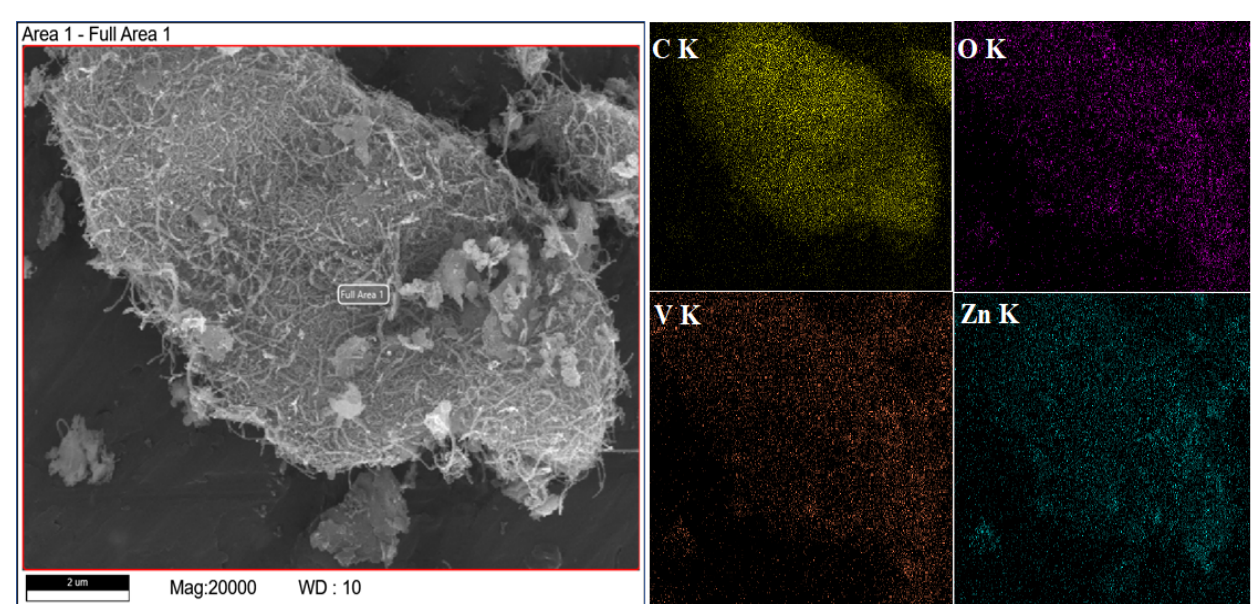
Figure 5. Elemental mapping of ZV@MWCNT.